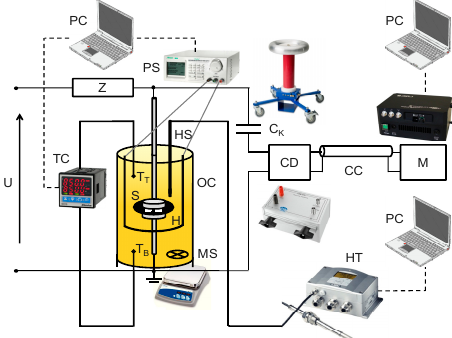
Figure 6. Schematic diagram of the measurement set-up: U: high-voltage supply; Z: short-circuit current limiting resistor; TC: temperature controller; T T : top-oil temperature sensor; T B : bottom-oil temperature sensor; H: immersion heater; PS: immersion heater power supply; S: oil-impregnated pressboard sample with electrodes; OC: hermetic glass chamber filled with mineral oil; MS: magnetic stirrer; HS: humidity and temperature sensor; HT: humidity transmitter; C K : coupling capacitor; CD: coupling device (measuring impedance); CC: connecting cable; and M: conventional PD measuring instrument (in accordance with standard IEC 60270 [28]).